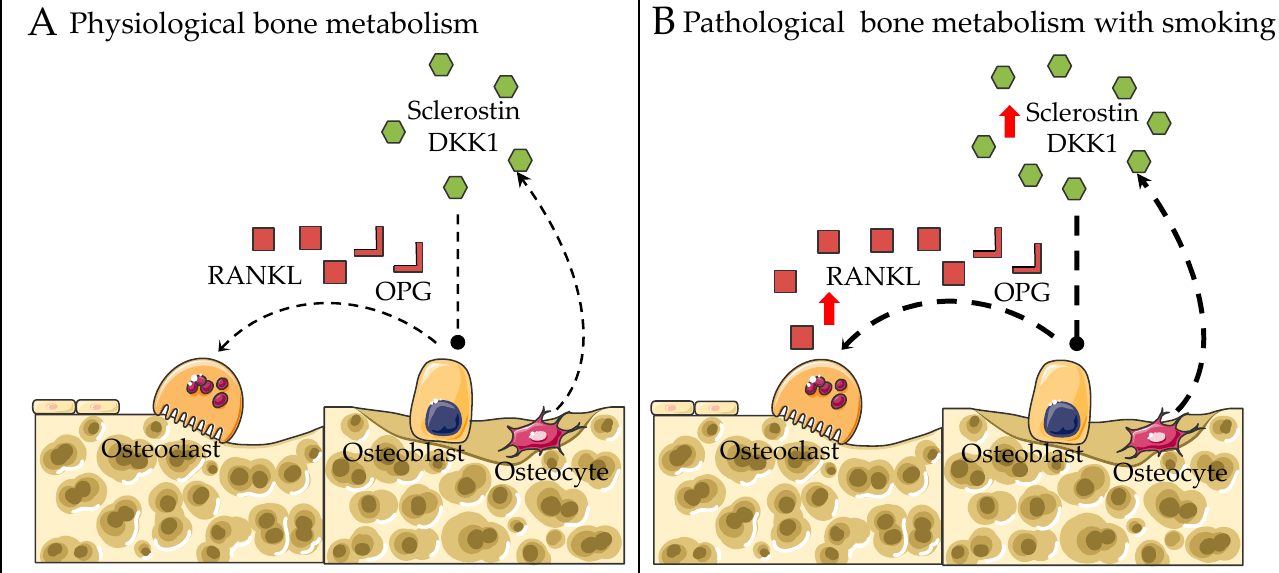
Figure 2. Proposed regulatory mechanisms for bone metabolism in ( A ) physiological conditions and ( B ) smoking exposure conditions. Dotted arrows represent expression. Red arrows represent altered expression (up or down).